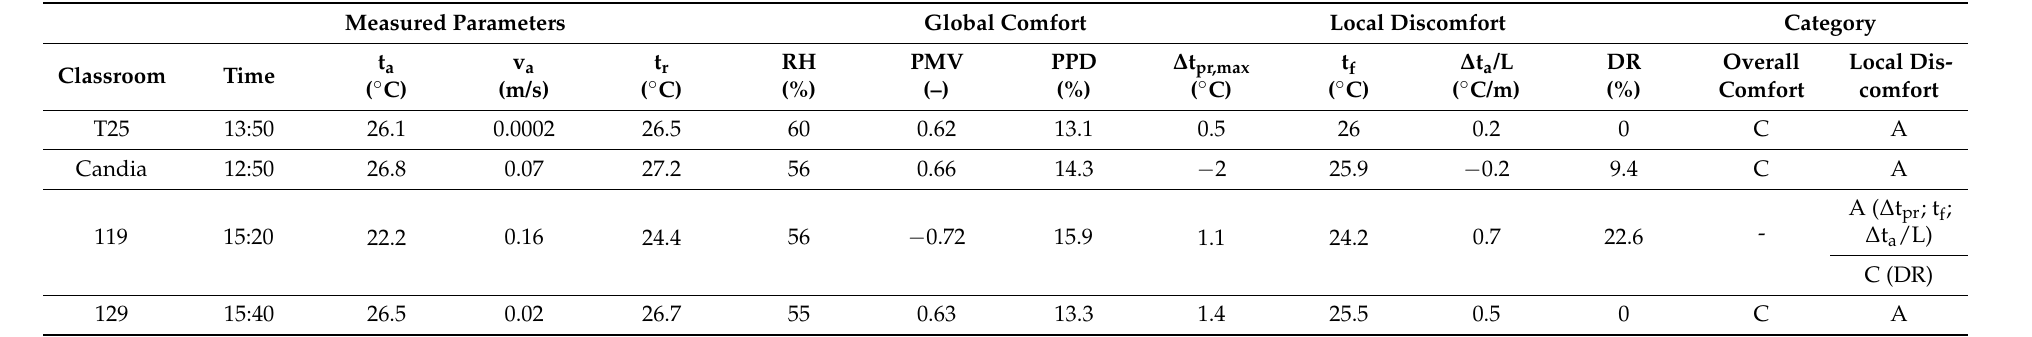
Table 4. Summary of thermal comfort measurements in some investigated classrooms. Environmental quality category was assigned according to ISO 7730 standard [64]. Legend: air temperature (t a ); air velocity (v a ) mean radiant temperature (t r ); relative humidity (RH); maximum plane radiant temperature asymmetry ( ∆ t pr,max ); floor temperature (t f ); air temperature vertical gradient ( ∆ t a /L); percentage of dissatisfied due to draught